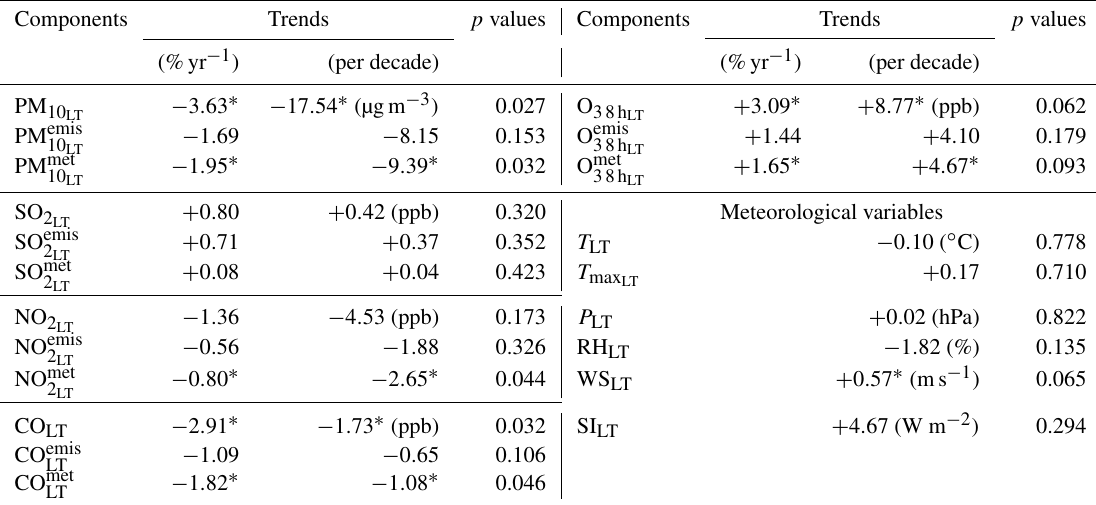
Table 4. Linear trends of long-term components of air pollutants and meteorological variables in Seoul for the period between July 2000 and June 2015.